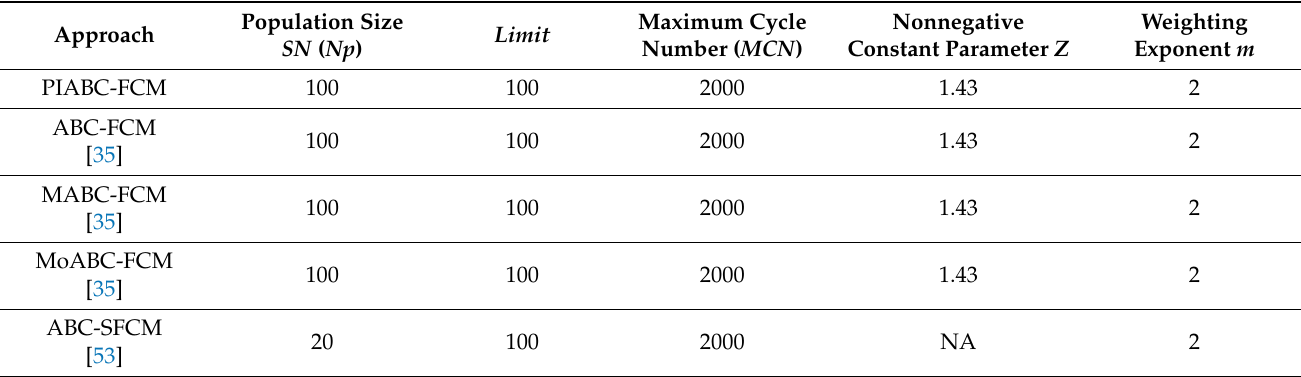
Table 1. The Summary of Parameters Values from state-of-the-art methods.